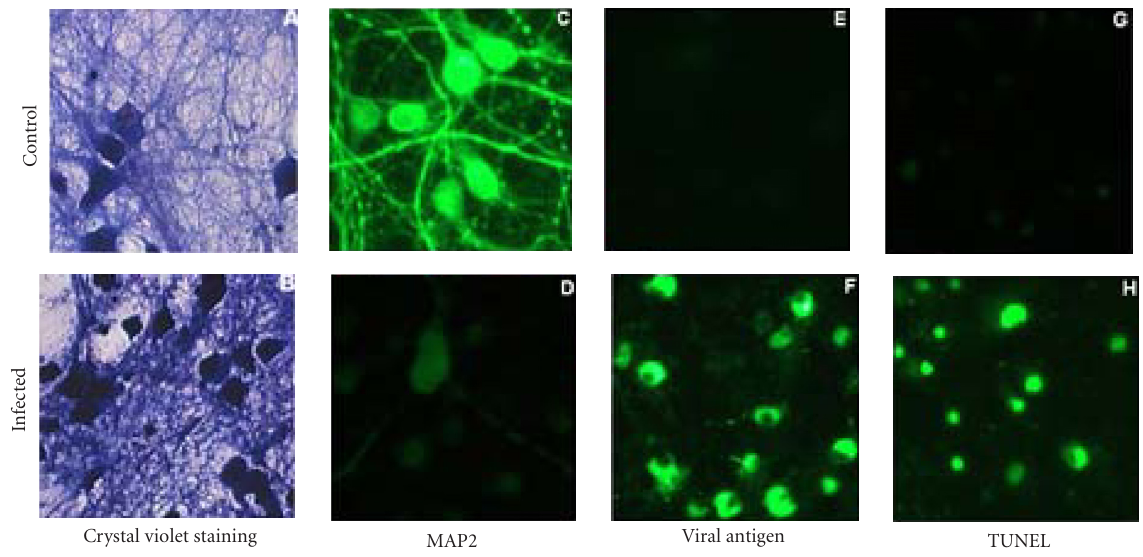
Figure 4. Crystal violet staining (A, B), MAP2 staining (C, D), WNV antigen staining (E, F), and TUNEL assay (G, H) of primary culture of rat cortical neurons. Uninfected control neurons morphologically look normal, with thick processes among neuronal bodies (A), while infected neurons show necrotic and apoptotic characteristics, including nuclear condensation, fragmentation, with most processes dissolved (B); WNV viral antigen staining shows bright cytoplasmic fluorescence in infected neurons (F), with control cells negative (E). In TUNEL analysis, control neurons (G) look normal, while infected neurons (H) show fragmented and condensed nuclei characteristic of cells undergoing